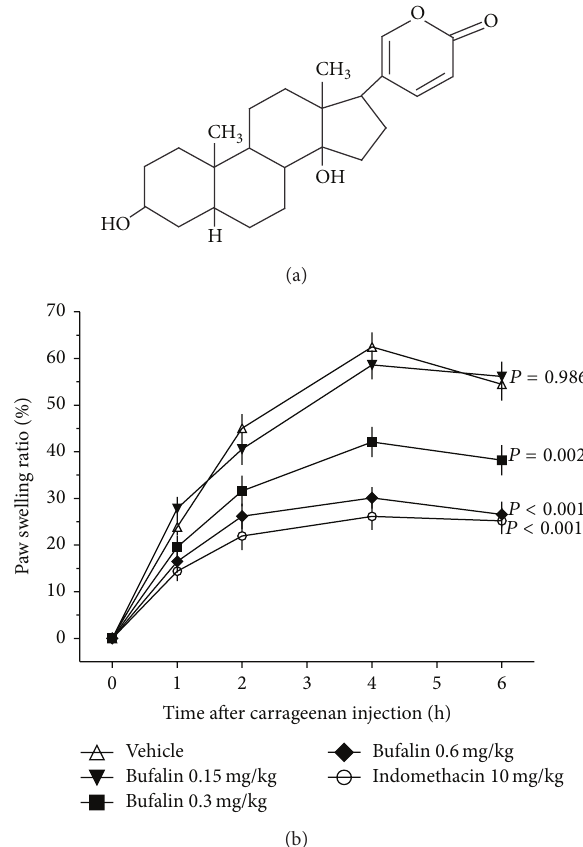
Figure 1: Effect of bufalin on carrageenan-induced rat paw edema. (a) Chemical structure of bufalin. (b) Bufalin at doses of 0.15, 0.3, and 0.6 mg/kg, the reference drug indomethacin at 10mg/kg, and the vehicle were administered to rats 30 min before carrageenan injection. The percentage of increase in paw volume of the right hind pawsofeachratateachtimepointwascalculated.Dataareexpressed as the mean ± S.E.M. ( 𝑛 = 8 ), P value, compared with the vehicle